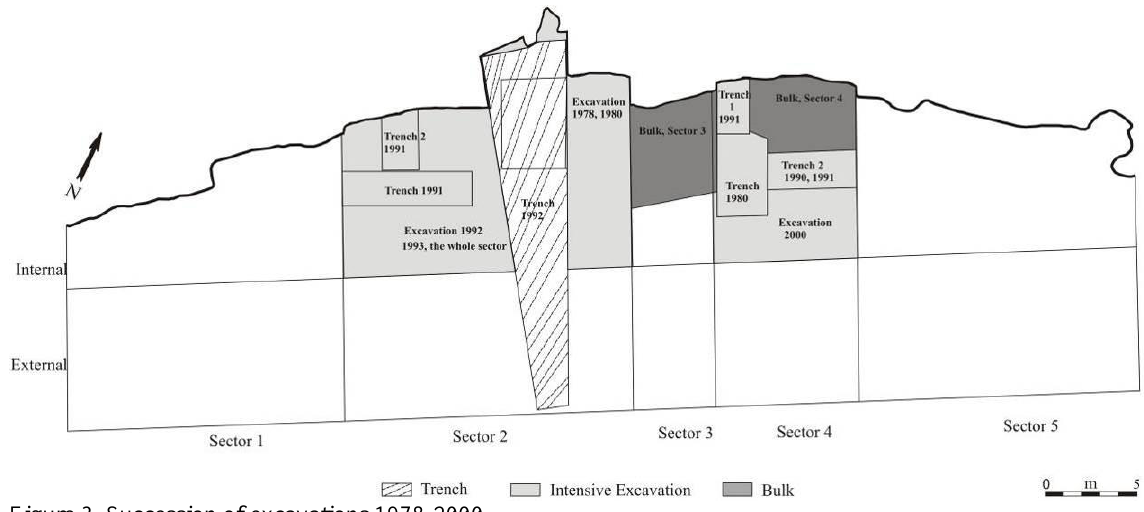
Figure 3. Succession of excavations